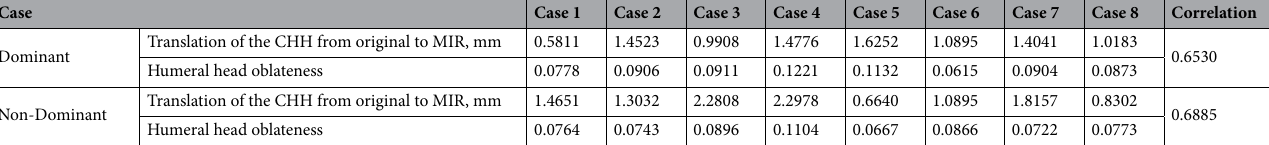
Table 3. Correlation between Translation the Center of Humeral Head and Humeral Head Oblateness. CHH: Center of humeral head. MIR: Maximum internal